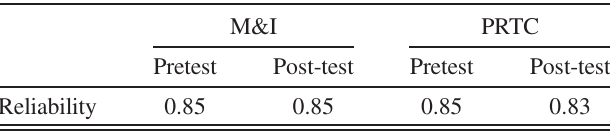
TABLE II. Reliability indices (KR-20) for the FCI pretests and post-tests in both courses.